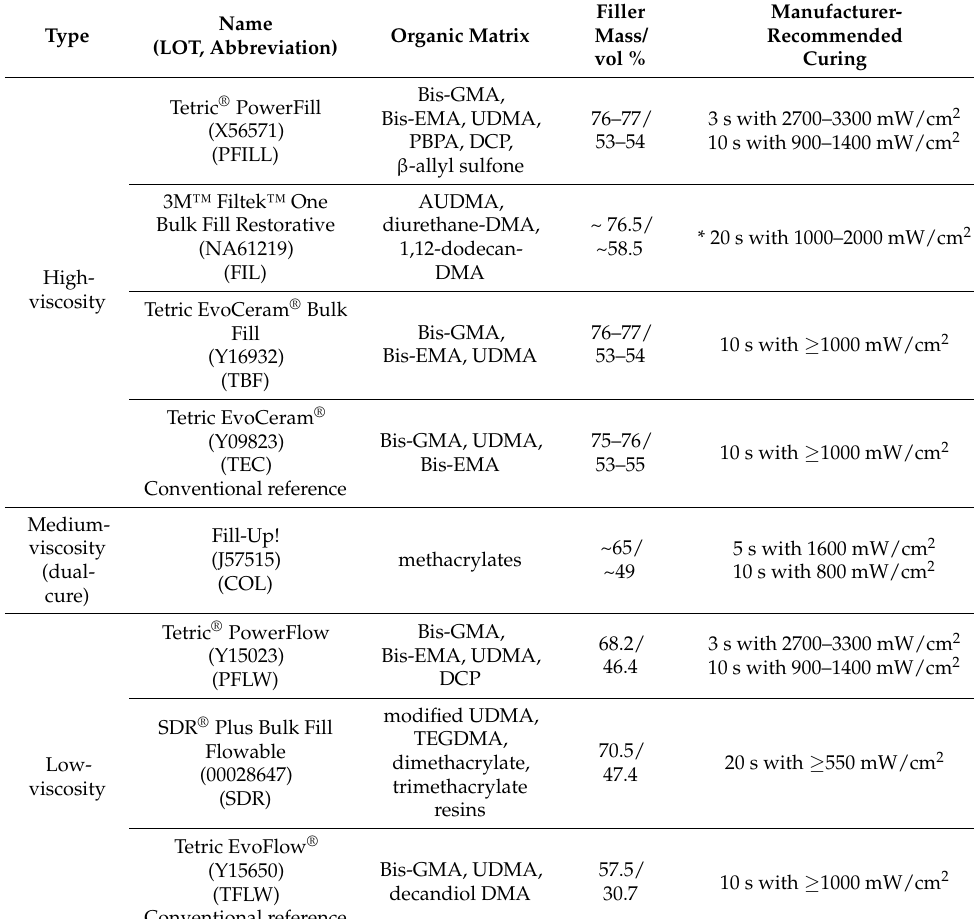
Table 1. Materials used in the study and the composition as provided by their respective